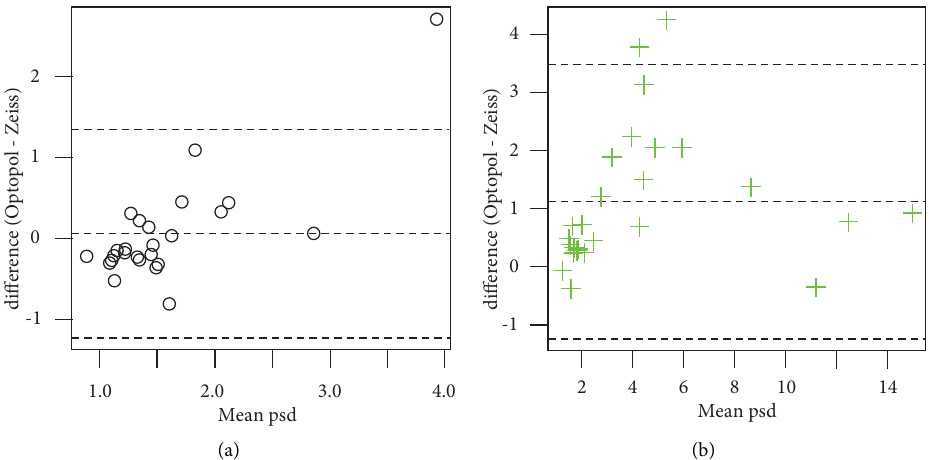
Figure 3: Bland–Altman plots for the visual field pattern standard deviations. For each subject, the mean of the measurement from the Zeiss and Optopol machines is taken and plotted on the x -axis. The y -axis is the difference between the Optopol and Zeiss measurements. The plot on (a) is for control subjects; the plot on (b) is for subjects with